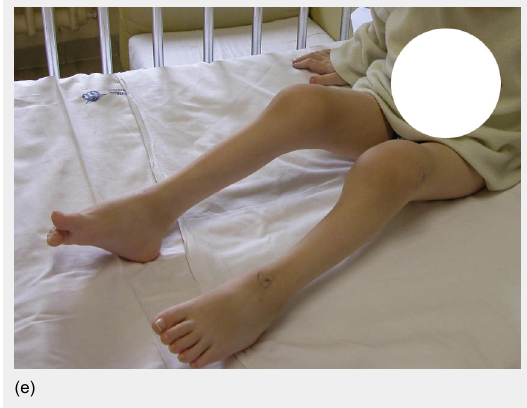
(a) Skin rash in a TRAPS patient; (b) Typical urticarial rash in a Muckle Wells patient carryng the D303N mutation; (c) Chronic papilloedema in a CINCA patient; (d) Typical boggy synovitis in a patient affected with Blau’s disease; (e) Bilateral pyogenic sterile arthritis of the knees in a 4-year-old patient with PAPA